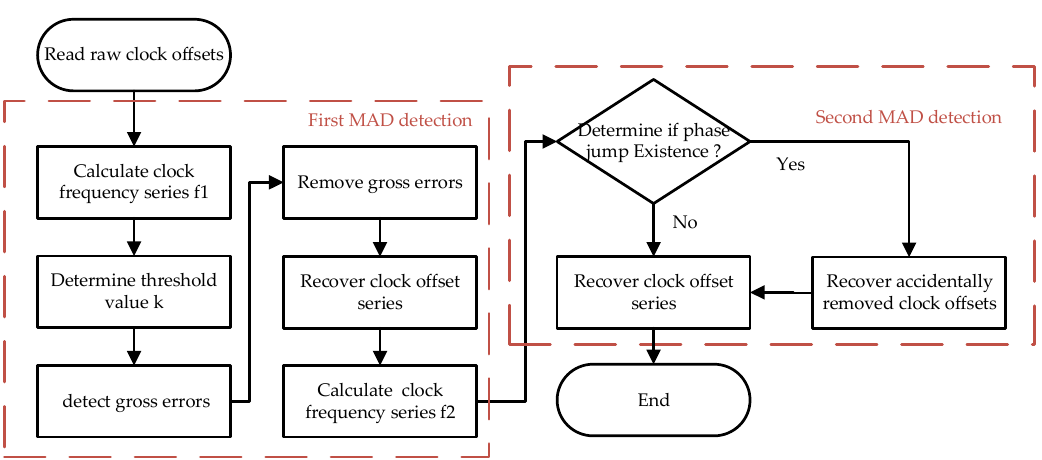
Figure 1. The flowchart of double MAD detection.